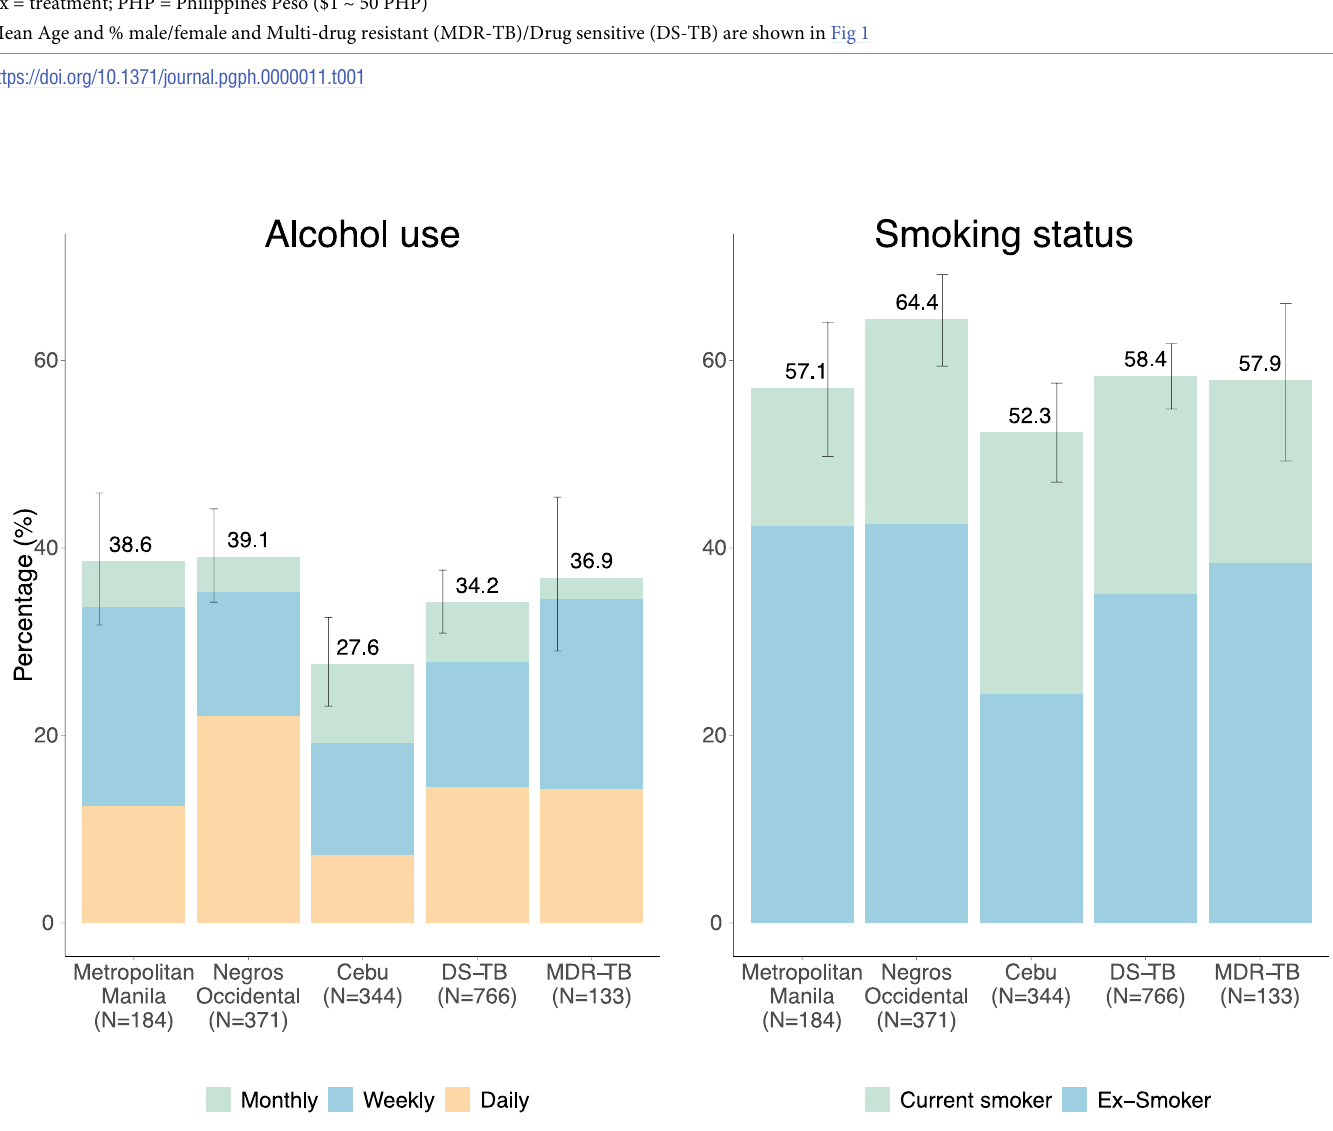
Fig 2. Prevalence of risk behaviours by region and by drug sensitive or multi-drug resistant TB treatment regimen. Footnotes: Smoking status: Prevalence of smoking differed significantly by region (chi2, p = 0.004) but not by MDR vs DS TB treatment regimen (chi2, p = 0.92). The relative proportion of current compared to ex-smoking behaviour differed significantly by region (chi2, p < 0.001) but not by MDR vs DS TB treatment regimen (chi2, p = 0.31). Alcohol intake: Prevalence of reported regular intake of alcohol differed significantly by region (chi2, p = 0.002) but not by MDR vs DS TB treatment regimen (chi2, p = 0.55). The frequency of alcohol intake in those that reported regular drinking differed significantly by region (chi2, p < 0.001) and by MDR vs DS TB treatment regimen (chi2, p =